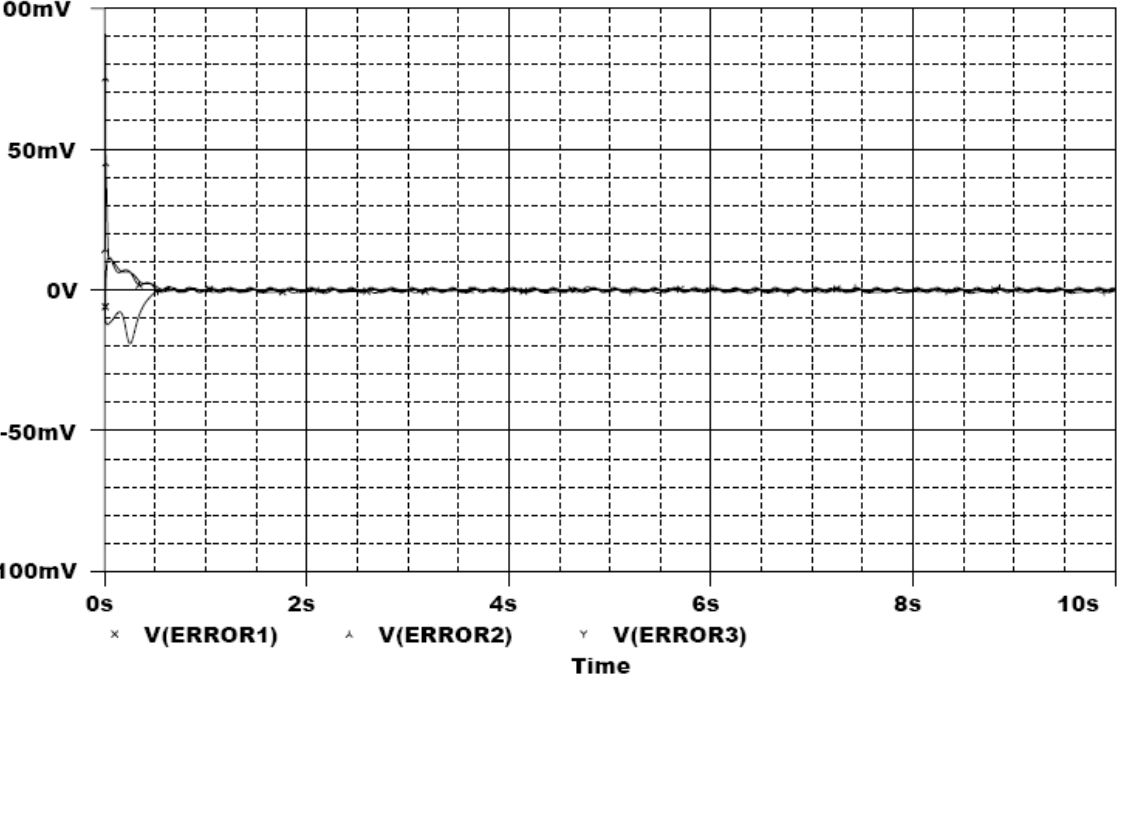
Figure 9. Experimental results of errors between state x